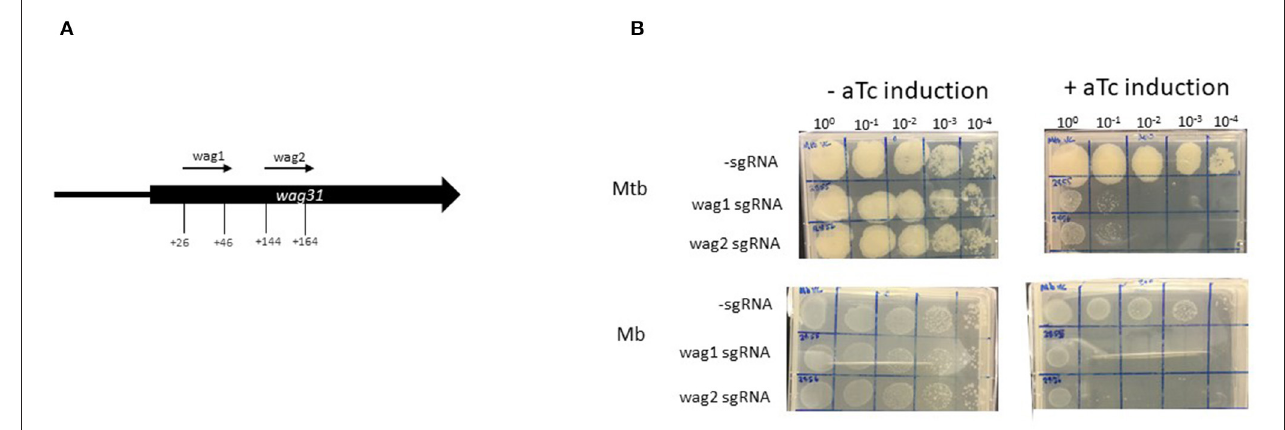
FIGURE 3 | Using CRISPRi/dCas9 to inhibit wag31 expression in M. bovis and M. tuberculosis. (A) Schematic showing the target regions of two sgRNAs designed to target and inhibit wag31 expression. The numbers show the nucleotide position of the sgRNA relative to the annotated start site. (B) CRISPRi strains were cultured in 10ml of supplemented 7H9 medium to exponential phase and diluted to 2 × 10 7 CFU/ml. A 10-fold serial dilution to 10 − 4 was performed and 20 µ l of each dilution was spotted onto 7H11 agar without aTc and with 200ng/ml aTc to induce CRISPRi/dCas9 and the sgRNA in those strains that carried the guide. Two biological replicates were carried